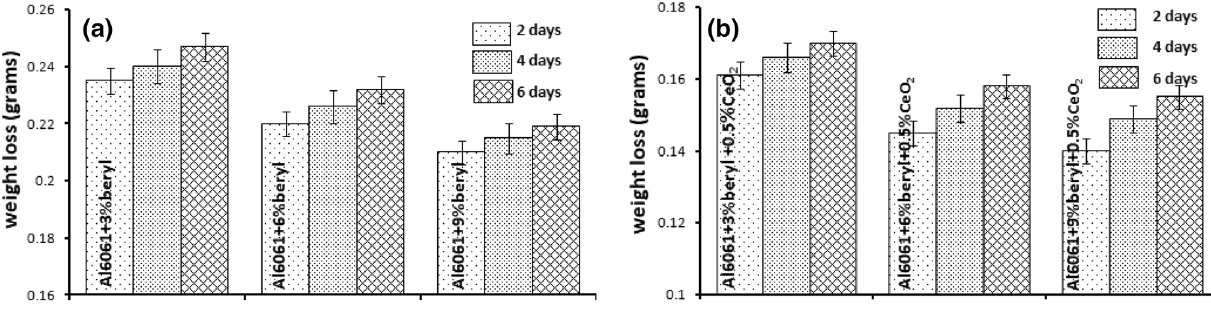
Fig. 12 Corrosion behavior of ( a ) “Al6061–Beryl” and ( b ) “Al6061–Beryl–CeO